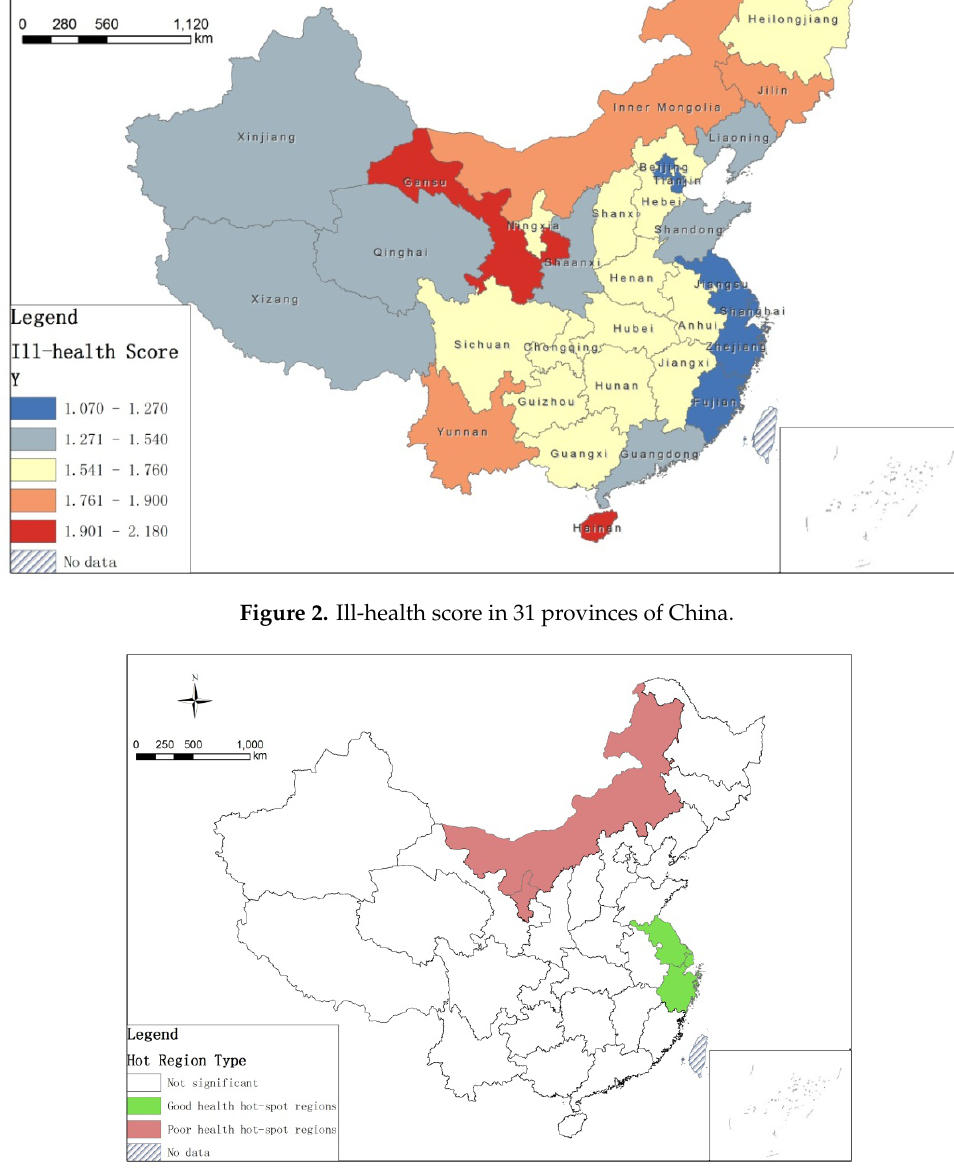
Figure 3. Local Moran's I cluster map of China's elderly health.